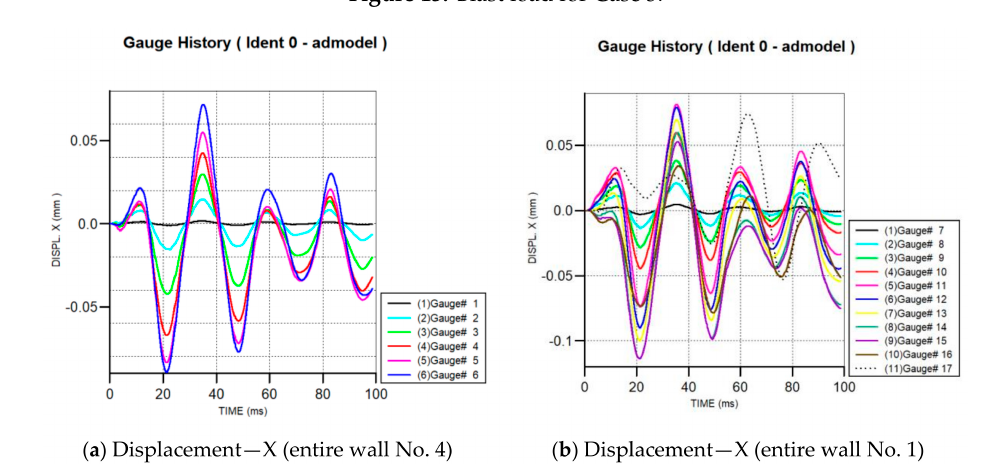
Figure 13. Blast load for Case 3.